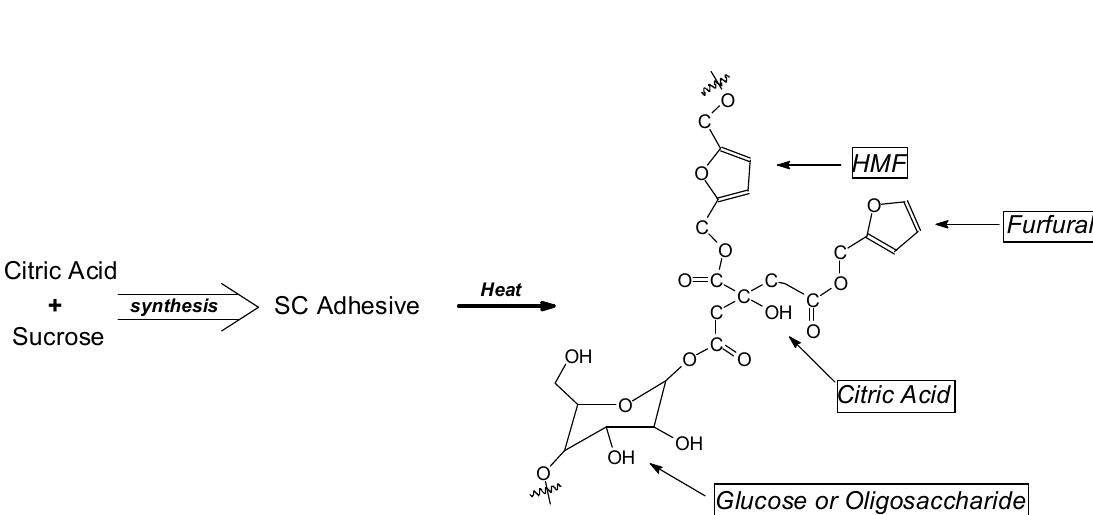
Figure 4. Example of citric acid bridges linking glucoses or holocellulose chains, and actually identified reaction products of citric acid with lignin. The compounds shown have been identified among several others of the same type, showing that both holocellulose and lignin are involved in wood bonding and citric acid bridge-forming by citric acid alone [116].